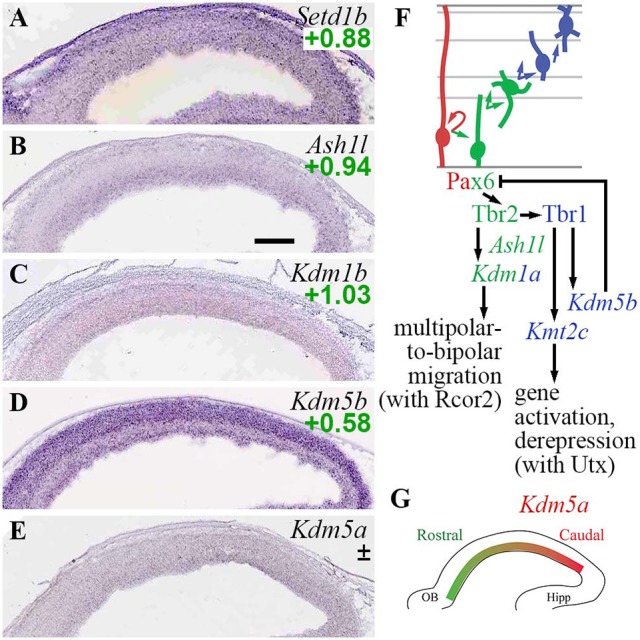
TrxG histone methylation/demethylation EFs. (A–E) Expression of indicated genes. The plus/minus symbol (±) indicates that different probes for the same gene, in this example Kdm5a
(E), showed enrichment in both Tbr2-GFP+ and Tbr2-GFP– cells on microarray (conflicted). ISH: Genepaint. Scale bar: 100 μm. (F) Summary of gene expression and regulation. Interestingly, Tbr1 activated both H3K4 methyltransferase (Kmt2c; Mll3) and H3K4 demethylase (Kdm5b; Jarid1b) genes. (G) Expression of Kdm5a (high caudal) was not directly regulated by Pax6, Tbr2, or Tbr1.